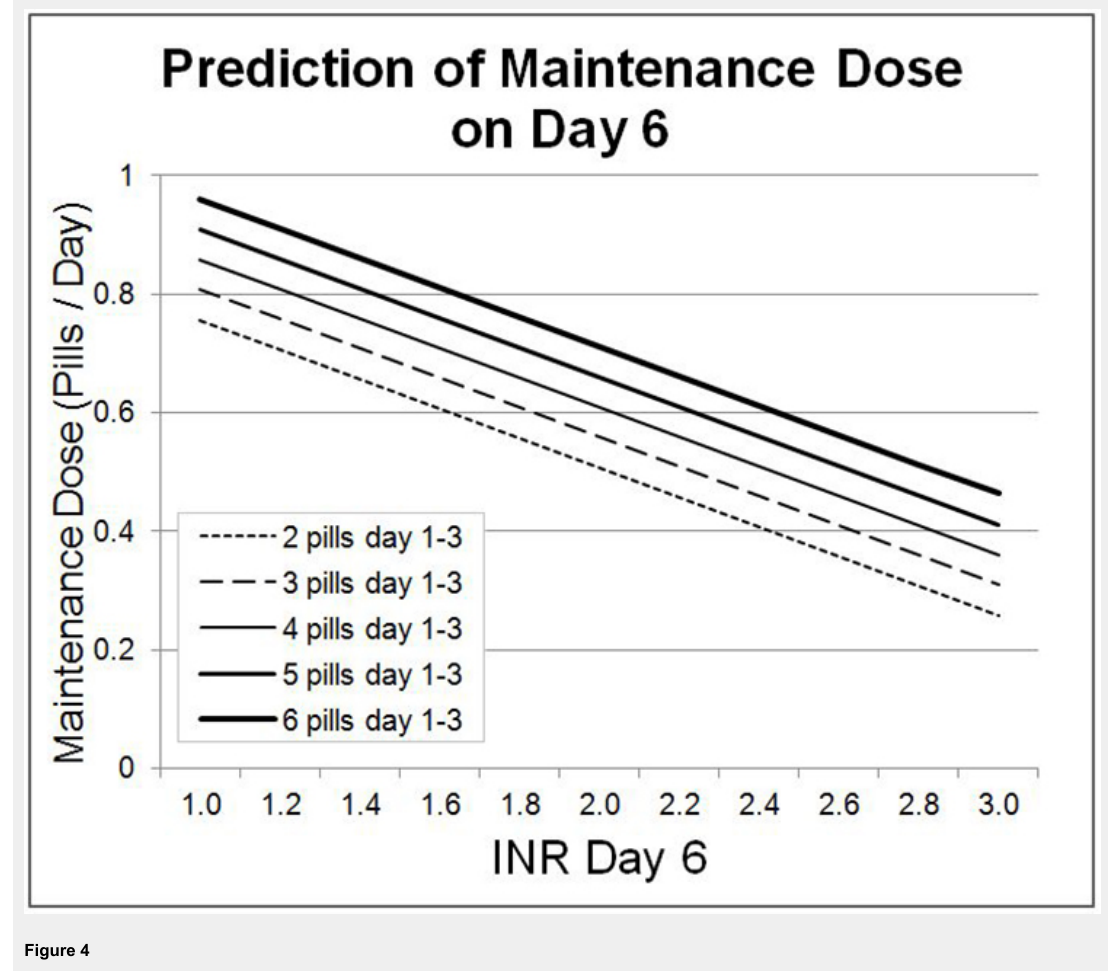
Figure 4 Prediction of maintenance dose on days 4 and 6